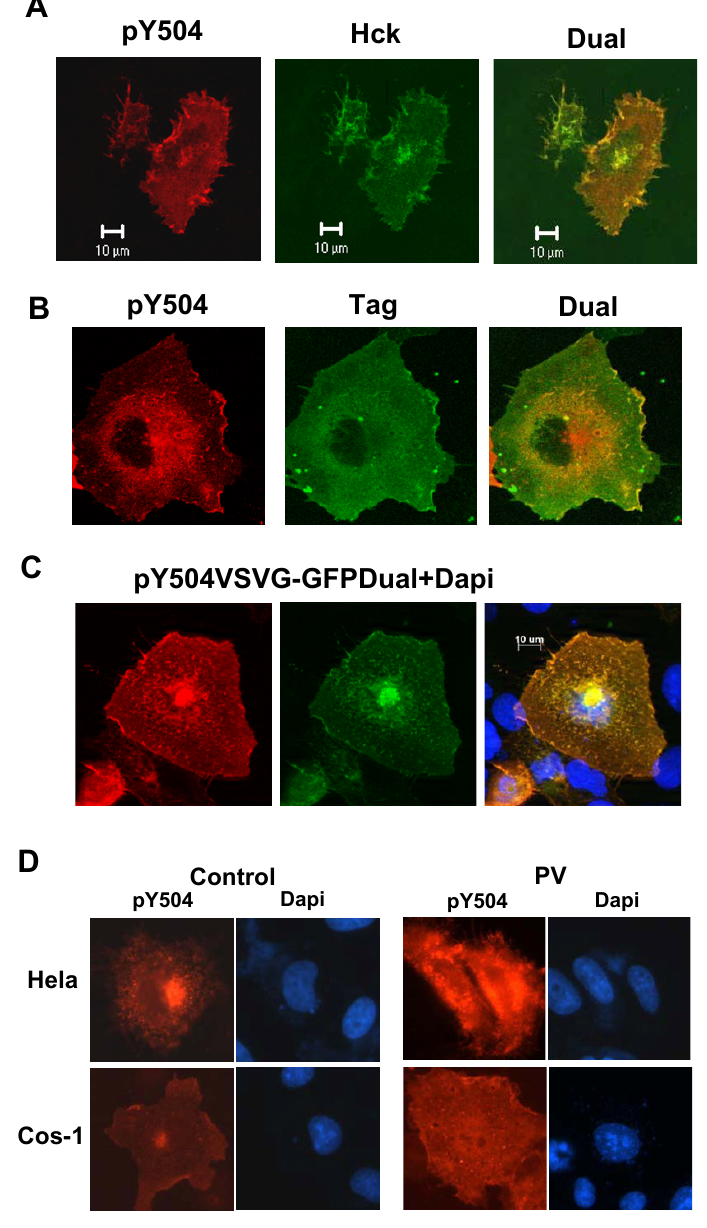
Figure 3 pY504-C3G colocalizes with Hck and shows predominant Golgi and membrane localization. (A) pY504 C3G colocalizes with Hck. Cos-1 cells transfected with Hck and C3G were stained for pY504 C3G (Cy3) and Hck (FITC) and exam- ined using a confocal microscope. Figure shows an optical section for the individual stains as well as that of the merged (Dual) image. (B) Cos-1 cells transfected with Hck and C3G were dual labeled to detect phospho-C3G (Cy3 staining) and C3G using the Flag tag antibody (FITC staining). Panels show optical sections taken using the confocal microscope. (C) pY504 C3G is localized to the Golgi apparatus. Cos-1 cells were transfected with Hck, C3G and VSVG-GFP expression constructs and stained using pY504 primary antibody and Cy3 conjugated secondary. An optical section taken using the apotome is repre- sented. (D) HeLa or Cos-1 cells transfected with Hck and C3G were left untreated (control) or treated with pervanadate (PV) prior to fixation and stained for pY504. Counter staining with Dapi shows cell